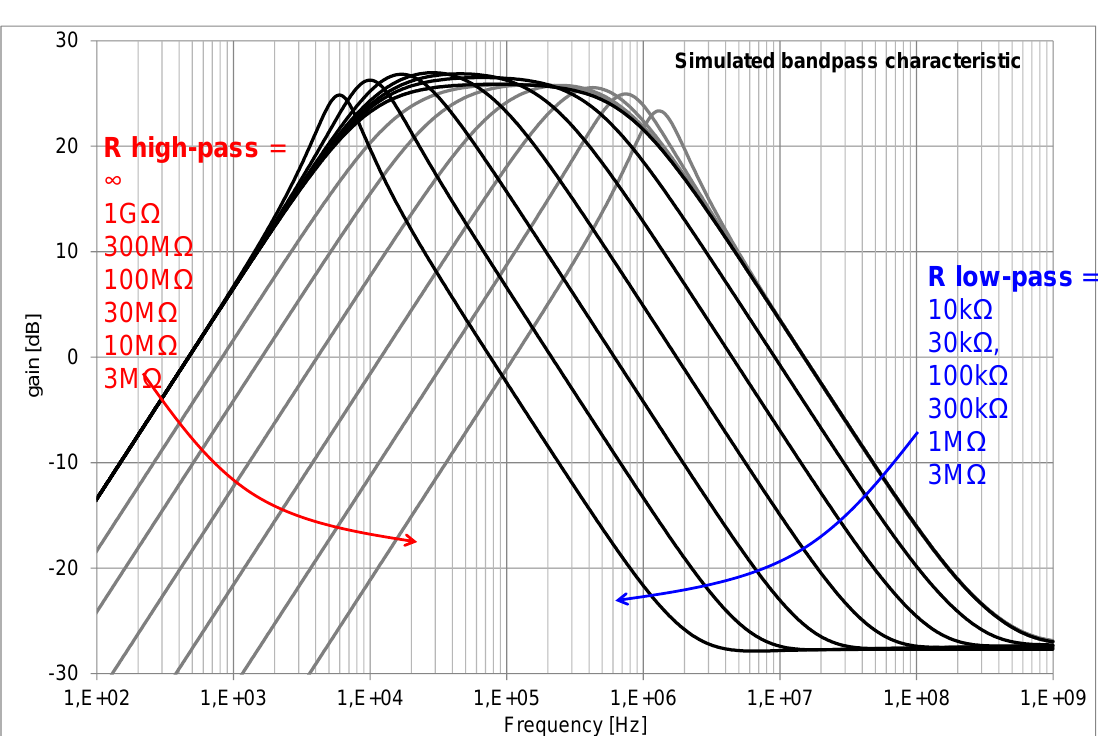
Figure 5. Simulated bandpass characteristics of the combination of pulse-shaper and comparator.